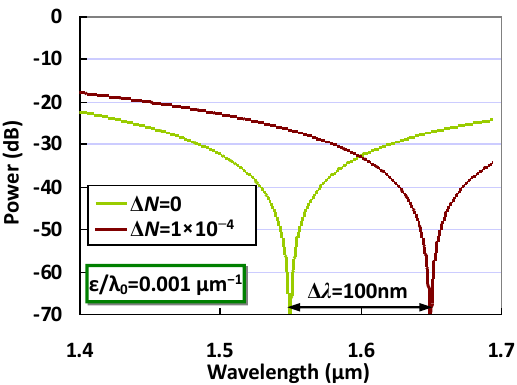
/ λ = 0.001 µ m − 1 0